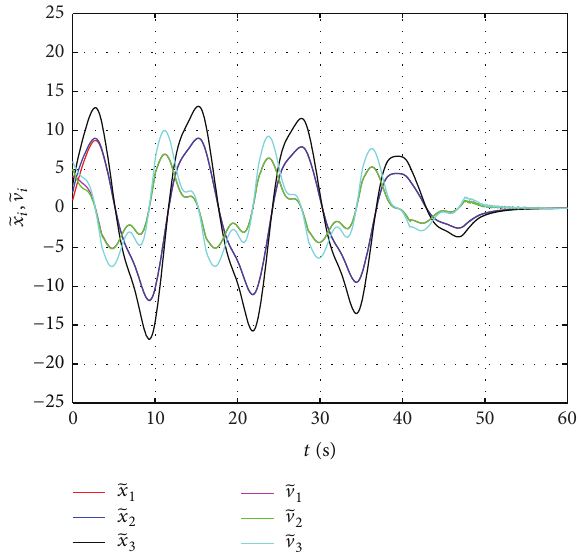
Figure 5: The norm of error 𝑒 𝑖 , 𝑖 = 1, 2,3, 4 , versus